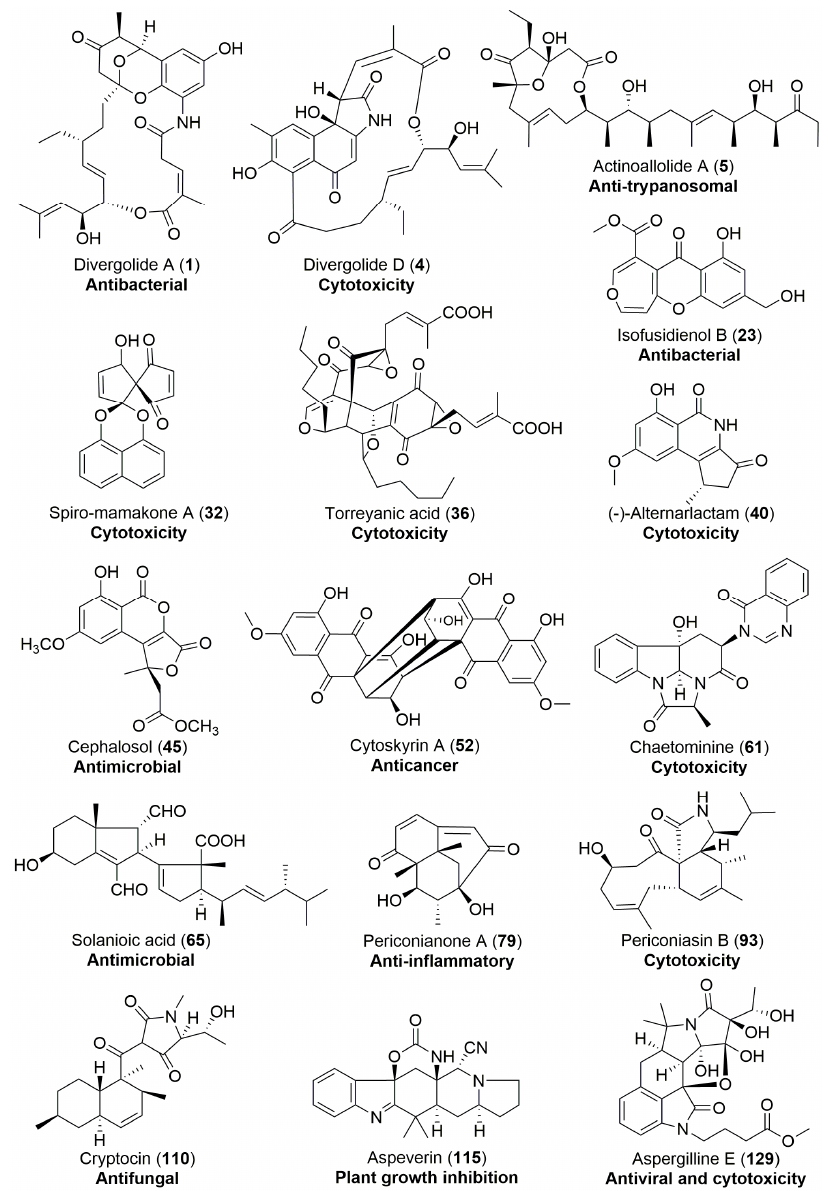
Figure 23. Selected endophyte-derived secondary metabolites with significant biological activities.